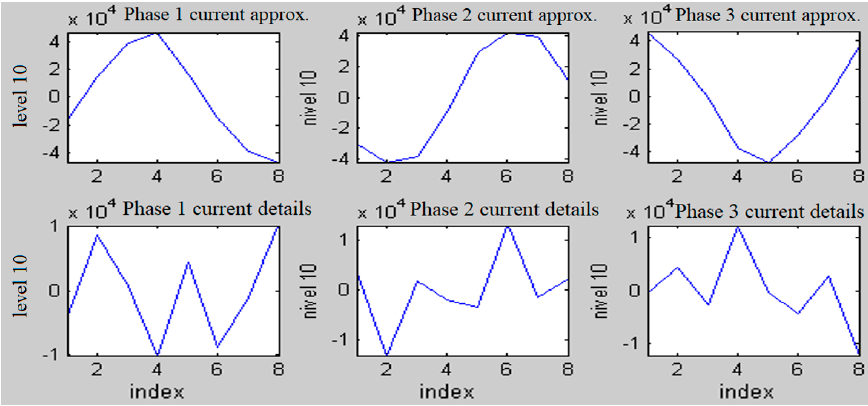
Energies 2022 , 15 , x FOR PEER REVIEW Figure 18. Vectors of details for currents, levels 7–9, first case study. Figure 18. Vectors of details for currents, levels 7–9, first case study.